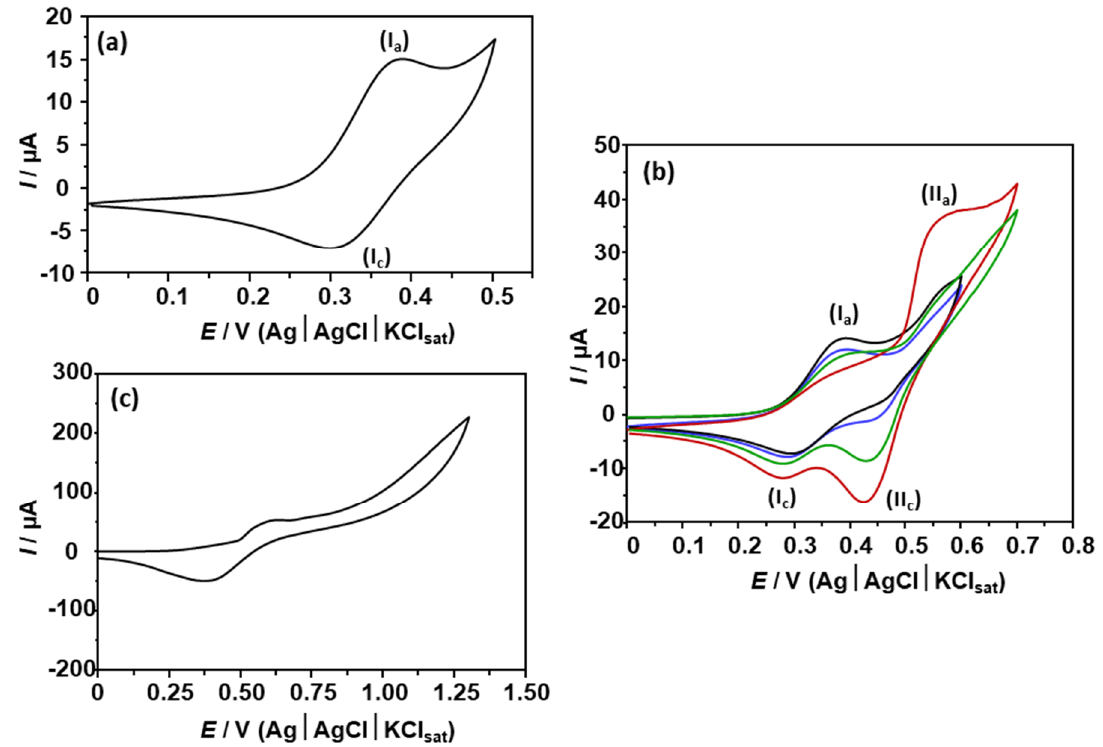
Figure A1. Cyclic voltammetry of compound 3a incorporated to the carbon paste electrode in phosphate saline buffer (pH 7.4). Scan rate = 50 mV/s. Potential scan from 0 V to +0.5 V; ( a ) +0.6 (first scan, black; second scan, blue) and +0.7 (first scan, green; second scan, red) ( b ) and +1.3 V ( c ).